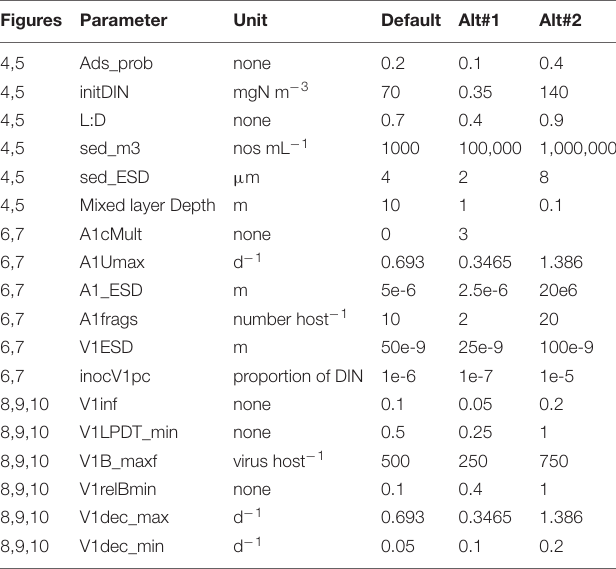
TABLE 5 | Configurations for the default simulation and for alternatives in Figures 4–10